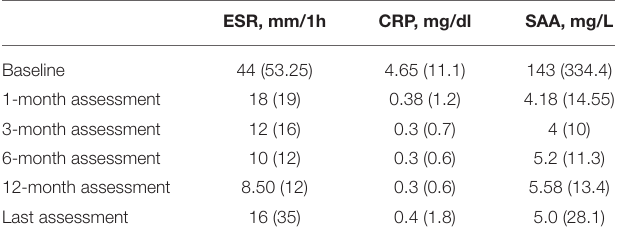
TABLE 2 | Laboratory values of erythrocyte sedimentation rate (ESR), C reactive protein (CRP), and serum amyloid A (SAA) at the start of treatment courses and at the following visits.